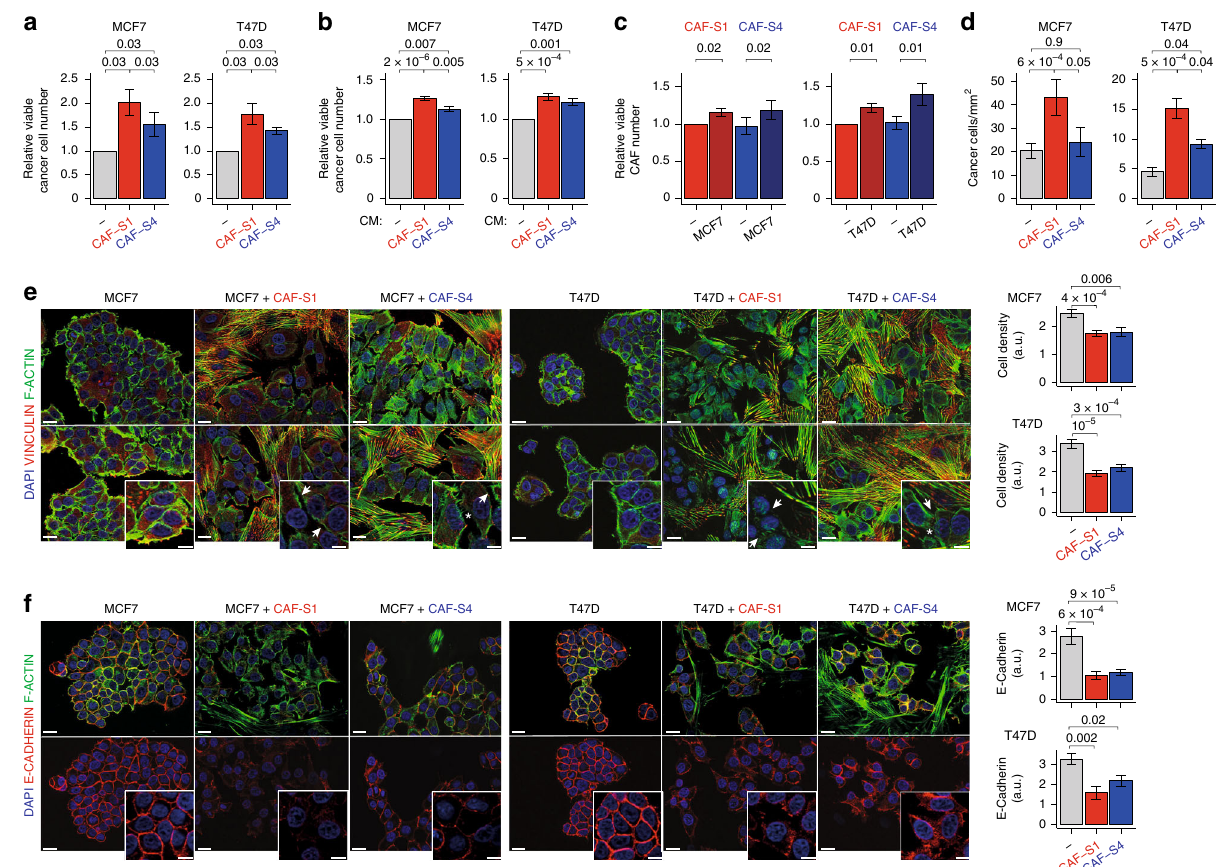
Fig. 5 CAF-S1 promote proliferation and initiate cancer cell epithelial-to-mesenchymal transition. a Total number of viable BC cells (Dapi − cells by FACS) in co-culture with CAF-S1 (red) or CAF-S4 (blue) relative to control ( − gray, without CAF) ( n = 6 per BC cell type). b Total number of viable BC cells (Resazurin staining) with CAF-S1- or CAF-S4-conditioned medium (CM) relative to control ( − , without CM) ( n = 9 per BC cell type). c Total number of viable CAF-S1 (red) and CAF-S4 (blue) (Dapi − cells by FACS) in co-culture with BC cells relative to control ( − , without BC cells) ( n ≥ 6 per BC cell type). d CAF-S1 and CAF-S4 capacities to attract BC cells ( n ≥ 8 per BC cells). e Left, Images of co-staining of Vinculin (red), F-actin (green) and DAPI (blue) in MCF7 (left) or T47D (right) cultured alone, or in presence of CAF-S1 or CAF-S4. Scale bars, 20 μ m; inset, 10 μ m. Arrows show reduced BC cell cohesion in presence of CAF-S1/-S4; asterisks show F-actin interconnections between BC cells in presence of CAF-S4. Vinculin and F-actin individual staining in Supplementary Fig. 4c. Right, Number of BC cells per tumor area (at least 13 images per condition, n = 3 per BC cell type). f Left, Images of E- cadherin (red), F-actin (green) and DAPI (blue) co-staining (top) or of E-cadherin (red) and DAPI (blue) staining (bottom) in BC cells alone or in presence of CAF-S1/-S4. Scale bars, 20 μ m; inset, 10 μ m. Right, Quanti fi cation of E-cadherin staining per BC cell area (at least eight images per condition) ( n = 2 per BC cell type). In all panels, barplots are mean ± SEM and n number of independent experiments; a. u., arbitrary units. a , d : p Values from Wilcoxon signed rank test. b , c : p Values from paired t -test. e right, f right: p Values from Student ’ s t -test (MCF7) and Mann – Whitney test (T47D). At least two CAF-S1 and CAF-S4 pairs tested, except in e , f for T47D, where one CAF-S1/-S4 pair is used. Source data provided in Source Data fi le, with R scripts